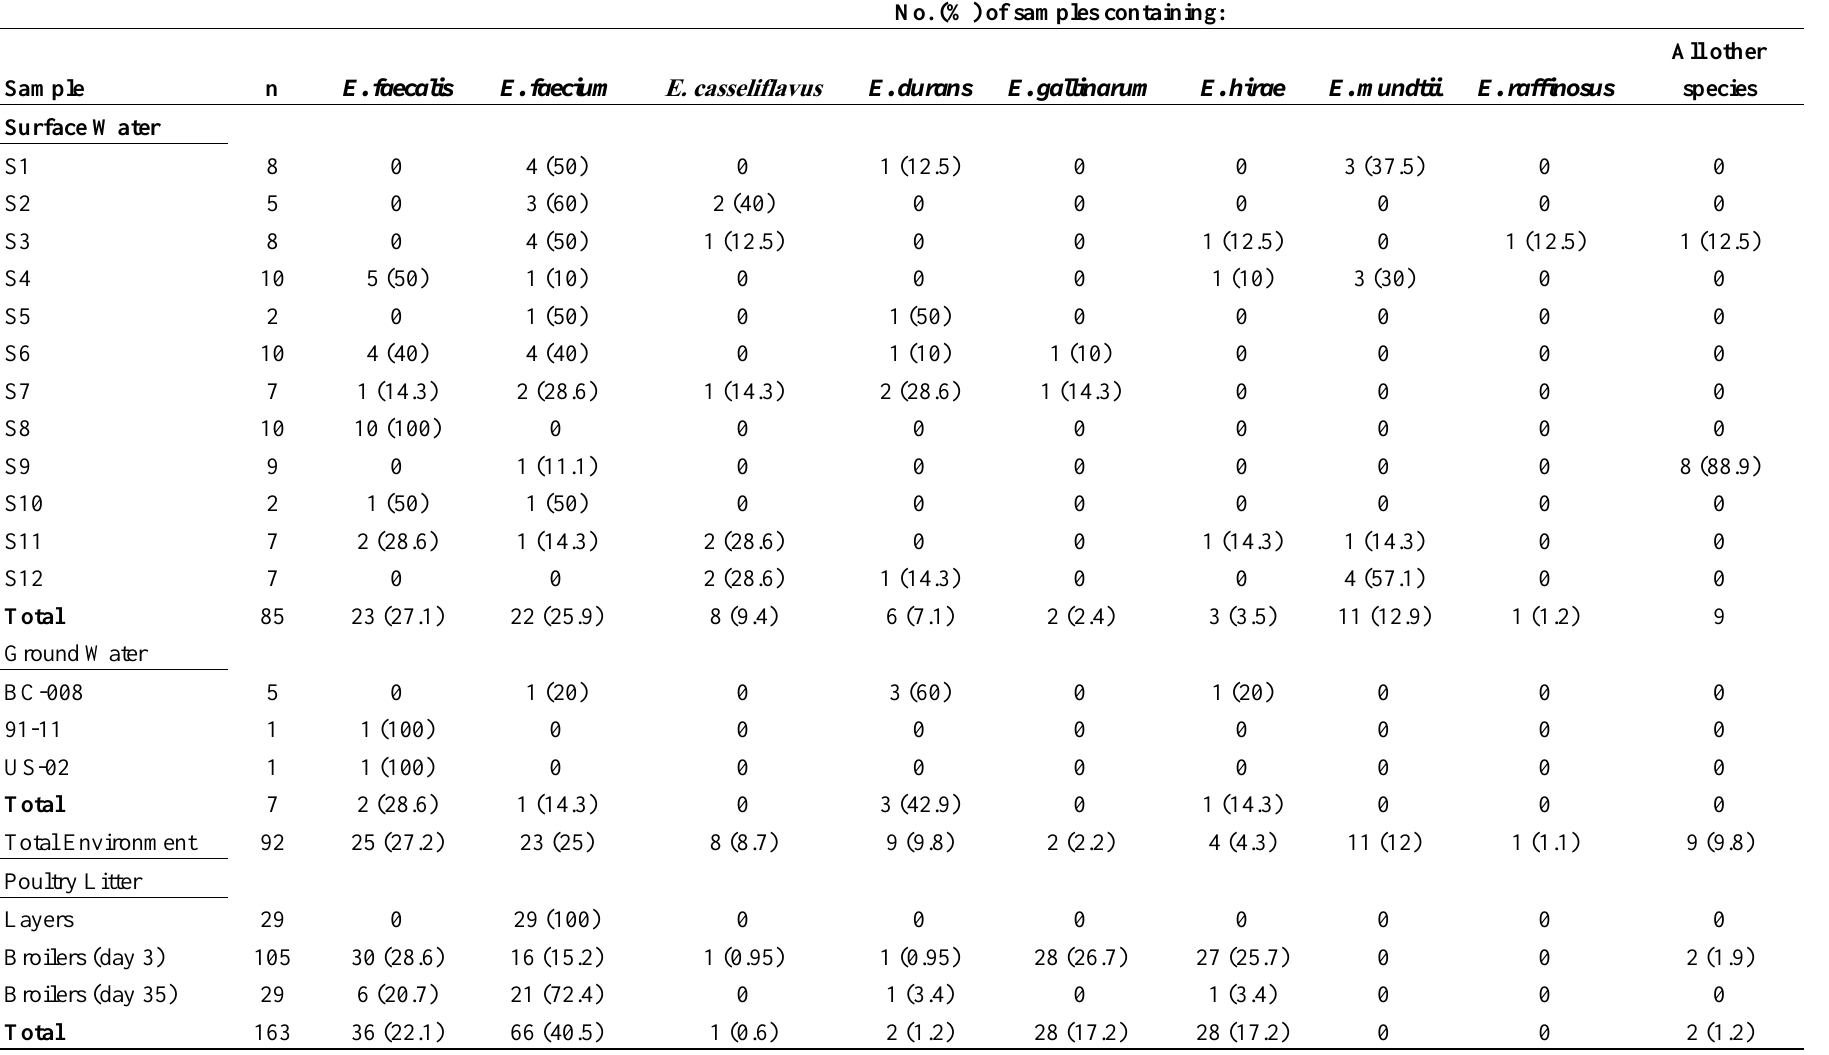
Table 1. Distribution of Enterococcus from surface water, ground water and poultry litter. No. (%) of samples